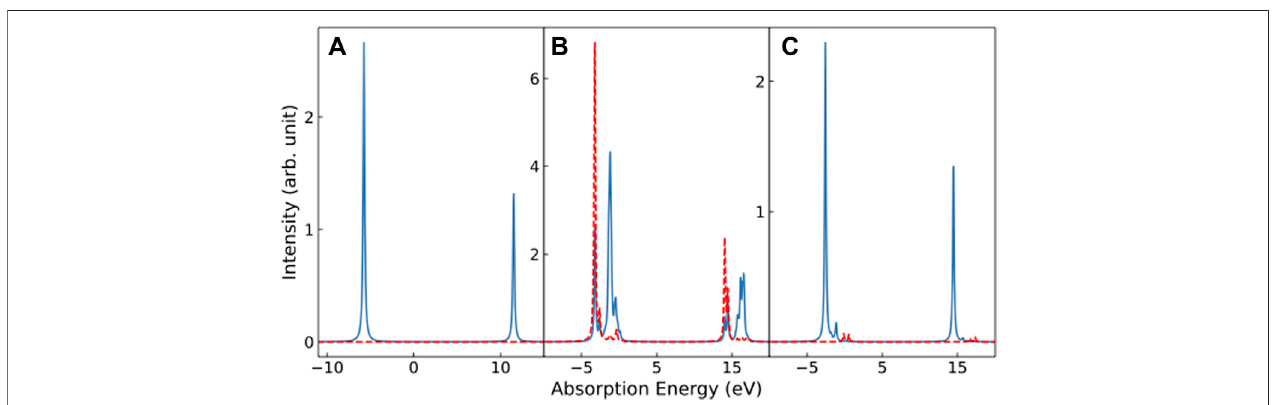
FIGURE3| MultipletXAScalculationsforthesingle-sitenickelion.Theabsorptionenergyismeasuredwithrespecttothegroundstateof d 9 ion.Thesolidlineisthe spectrameasuredwith x -polarizedlight,andthedashed lineisthespectrameasured with z -polarized light.Fromlefttorightarespectraof (A) the d 9 ion, (B) the d 8 high- spin ion, and (C) the d 8 low-spin ion.